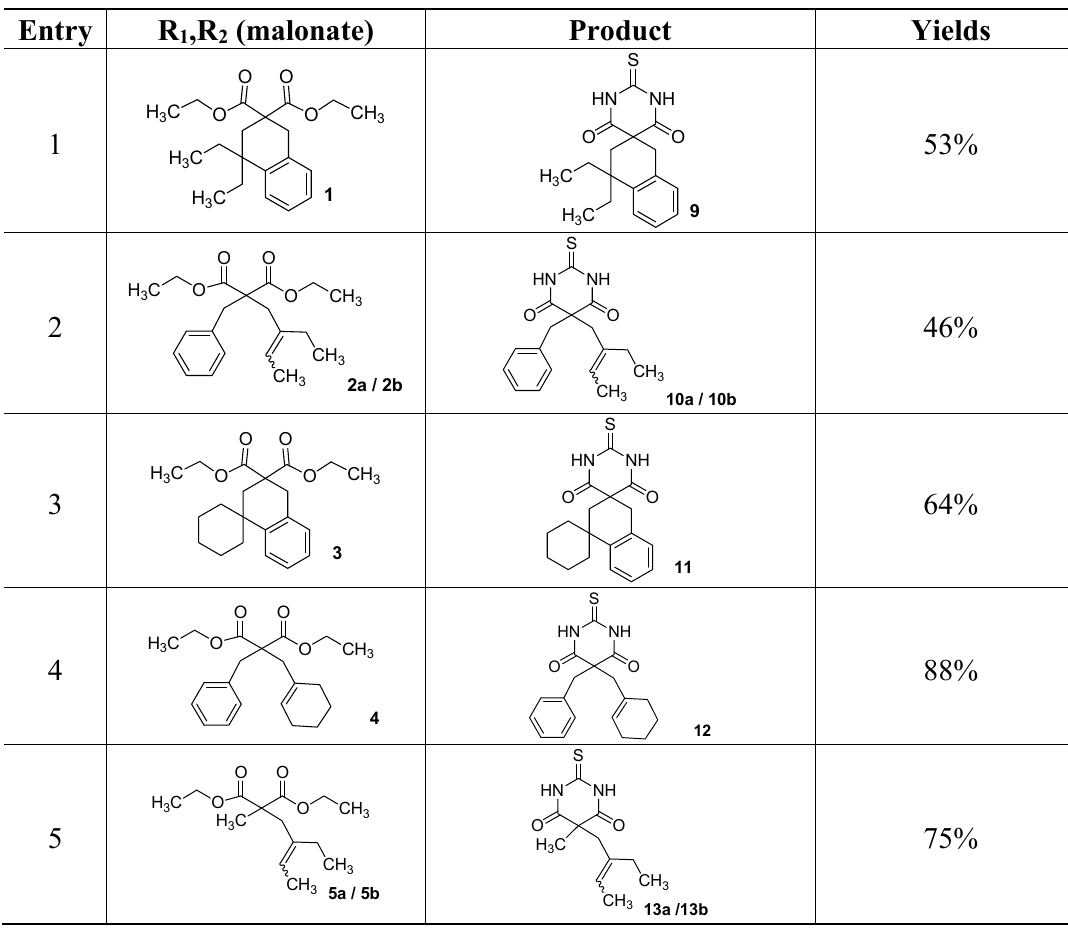
Table 1. Thiobarbituric acids 9 – 16 synthesis from malonates 1 – 8